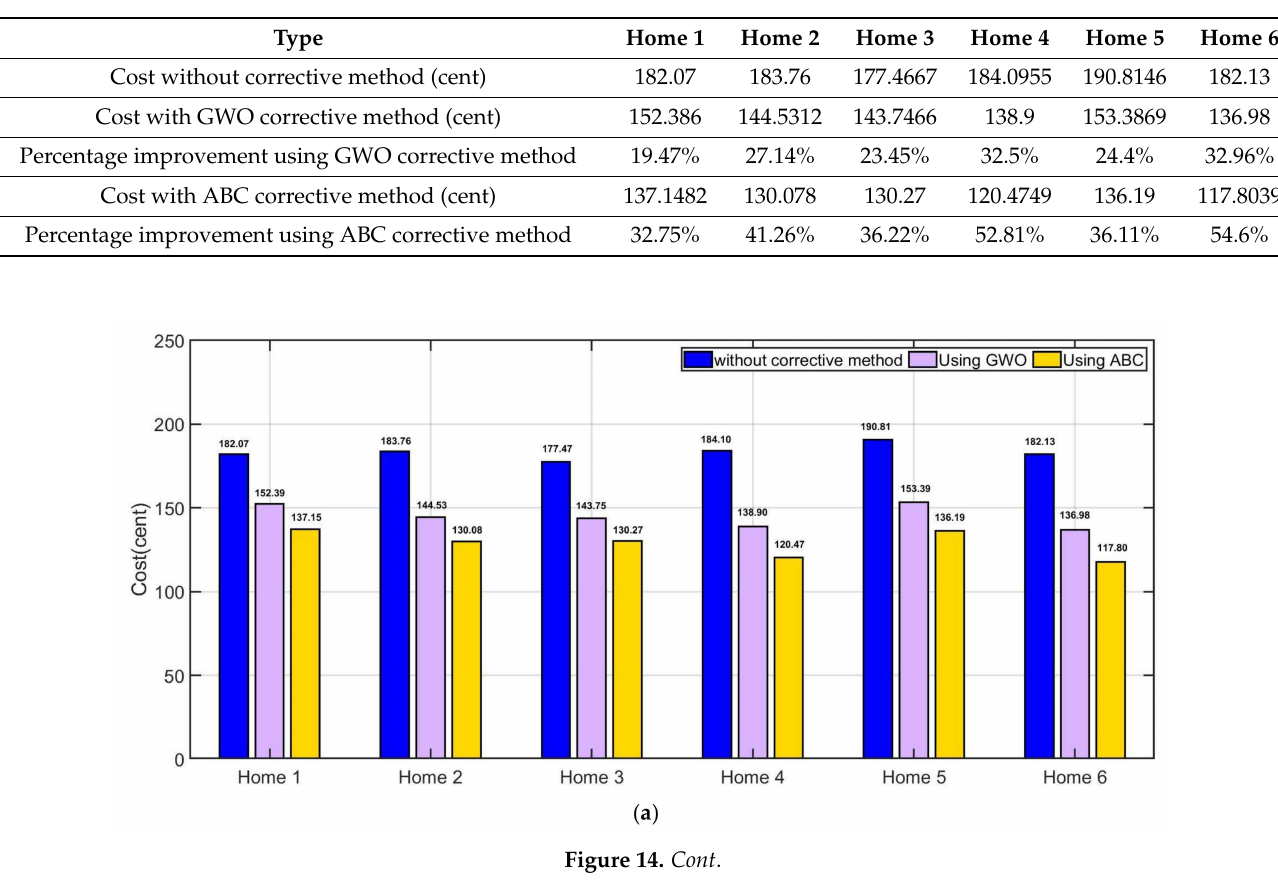
Table 4. Difference between with and without corrective method.